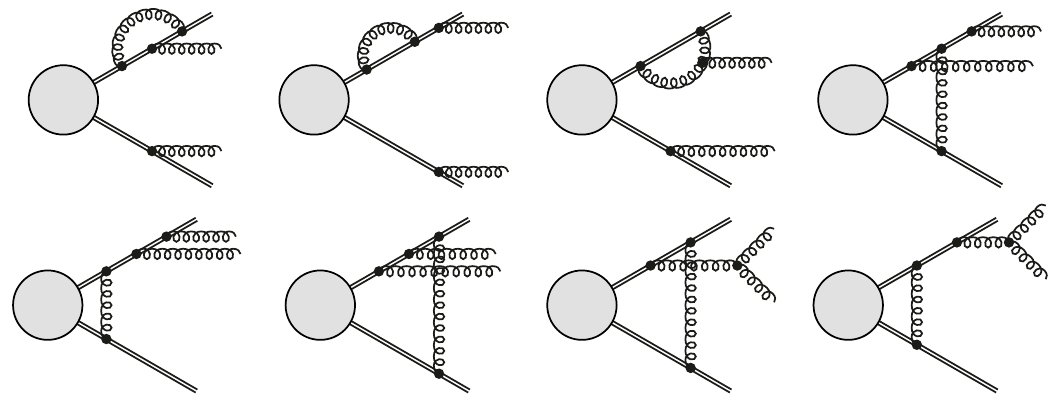
Figure 6 . Scaleless diagrams with two Wilson lines. Description as in figure 3.